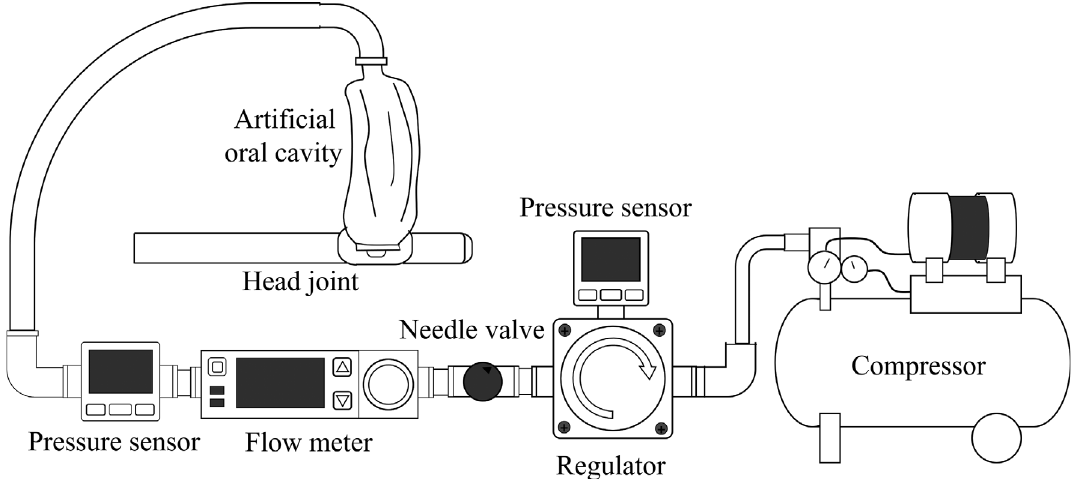
Figure 10. Schematic of arti fi cial blowing.